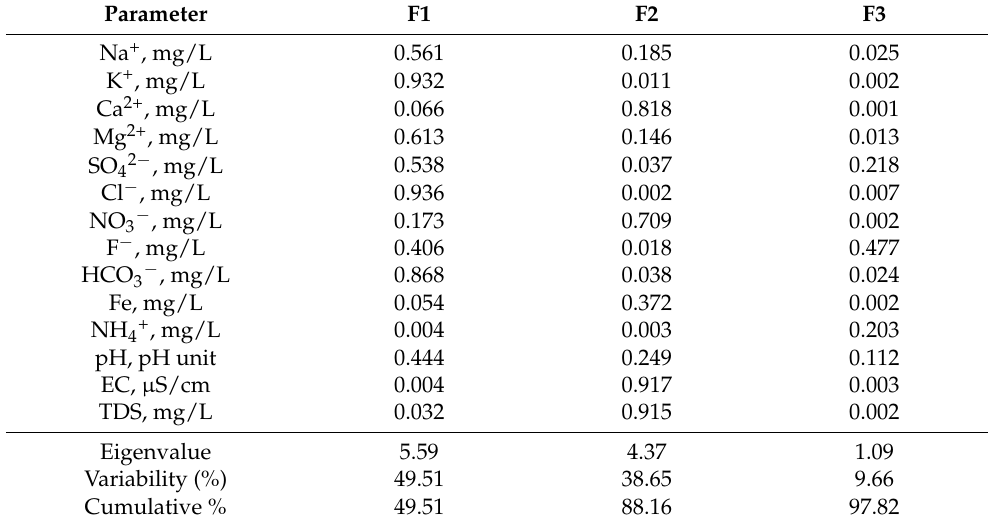
Table 5. Component matrix for different parameters.